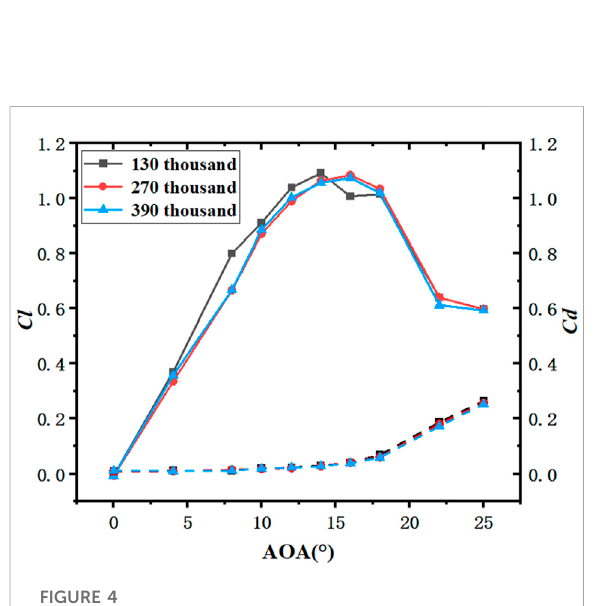
FIGURE 5 Comparing NACA0021 simulation data and experimental